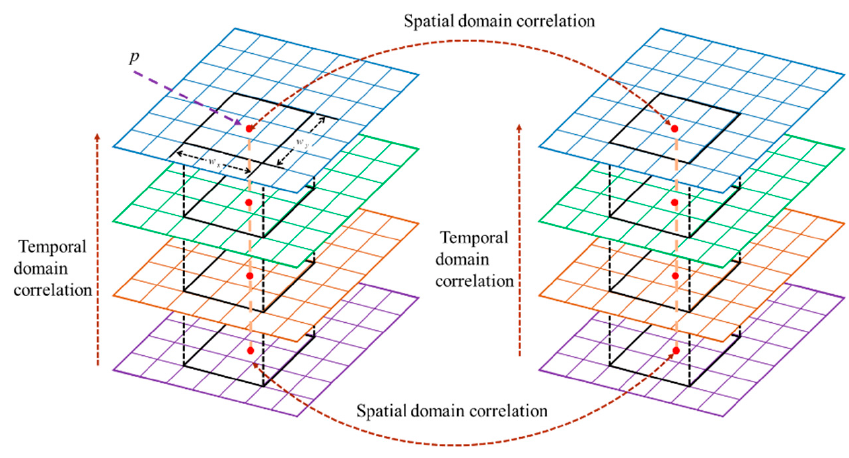
Figure 2. Schematic diagram of 3-dimensional face acquisition device with rotary speckle projector: ( a ) structure map of the device; ( b ) internal structure of the rotary speckle projector, where the ω . speckle mask rotates at angular velocity